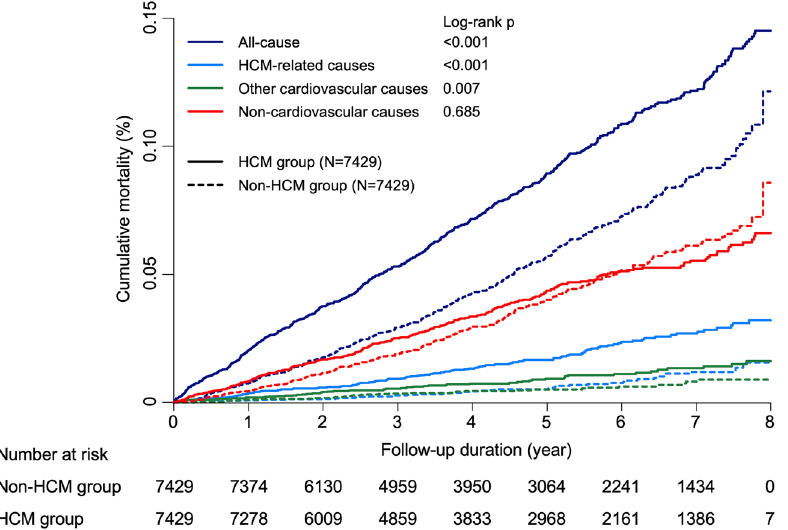
Figure 2. Cumulative mortality according to the cause of death. All-cause mortality, HCM-related mortality, and other cardiovascular mortality were significantly higher in the HCM group compared with those in the non-HCM group. Mortality from non-cardiovascular causes, however, were not significantly different between the HCM and the non-HCM groups. HCM hypertrophic